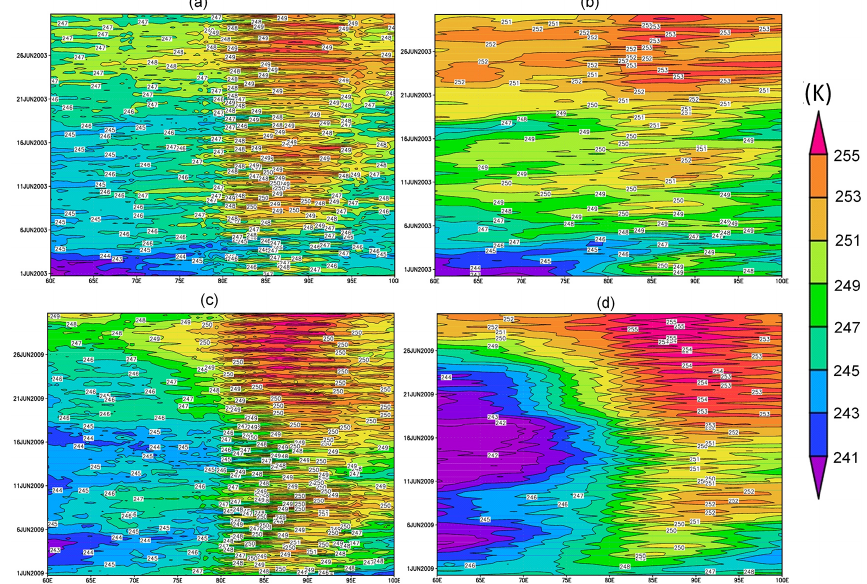
Figure 11. Time–longitude cross section at 30 ◦ N of the 500–200hPa layer temperature (in ◦ K) for the years 2003 (a, b) and 2009 (c, d) . The left panels (a, c) represent ARW simulation and the right panels (b, d) FNL analysis.